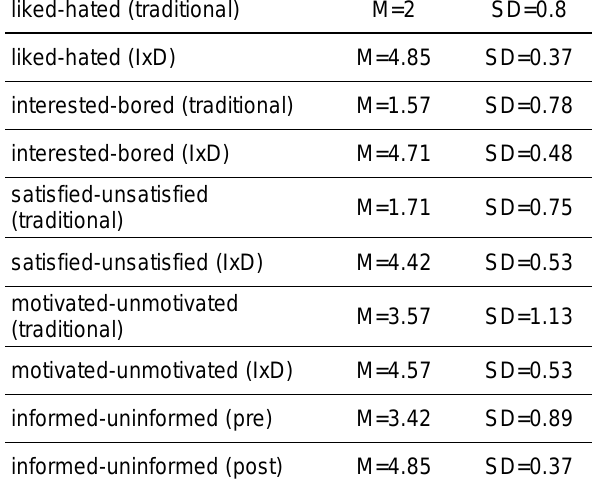
Table 4. User enjoyment and motivation based